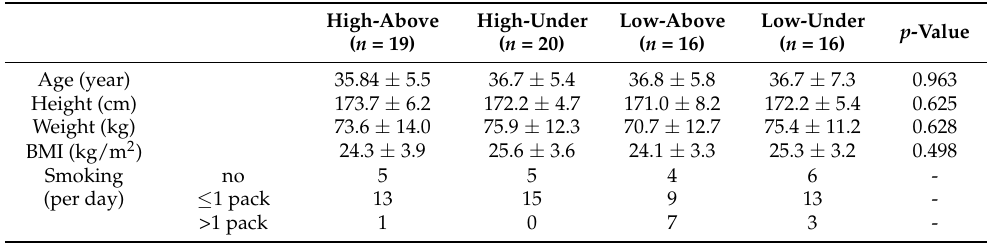
Table 1. Demographic